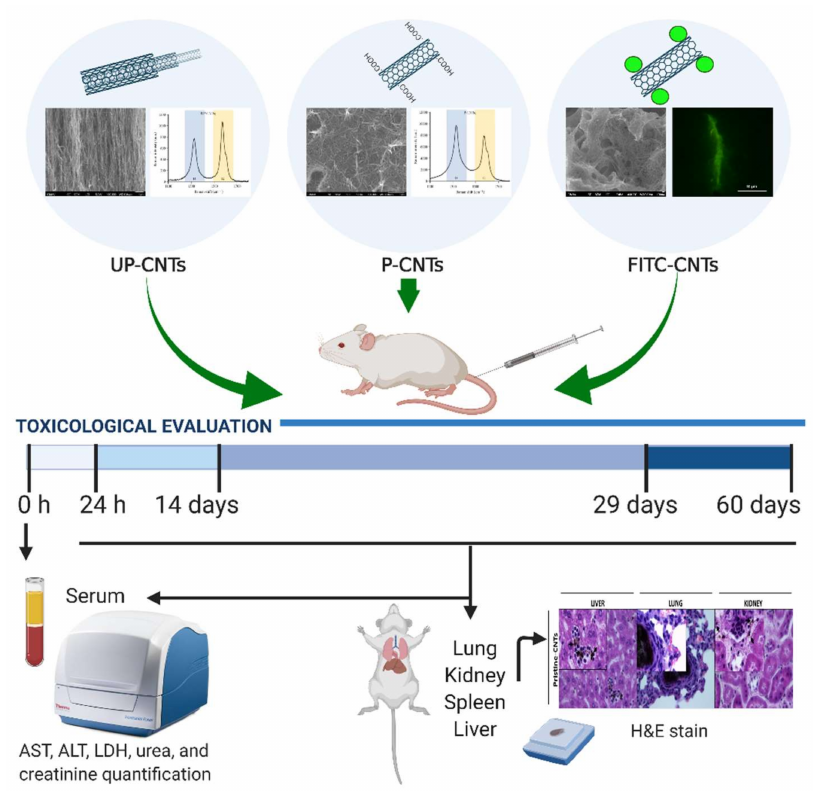
Figure 1. Timeline of exposure protocol for toxicological evaluation in BALB / c mice. The UP-CNTs